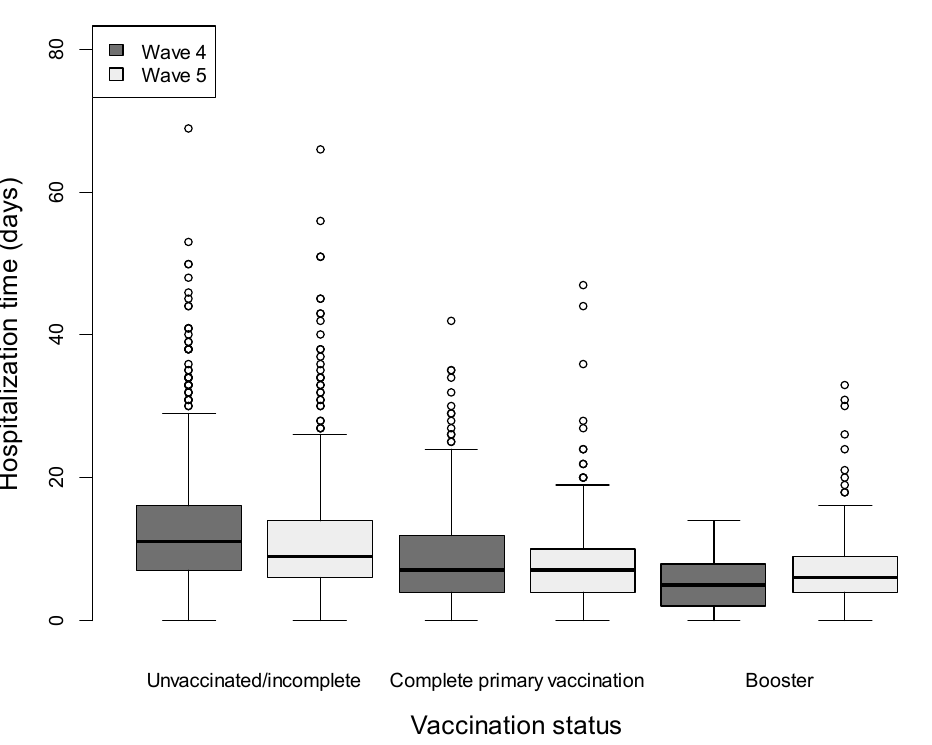
Figure 1. Duration of hospitalization in the three subgroups of patients (unvaccinated/incomplete vaccinated, complete primary vaccination, and booster) during the fourth and the fifth wave of the pandemic. Box represents median observations (horizontal rule) with 25th and 75th percentiles of observed data (top and bottom of box). The length of each whisker represents values up to 1.5 times the interquartile range. Table 2. Multiple quantile regression model predicting duration of hospitalization time in function of pandemic wave and vaccination status, adjusted for age and